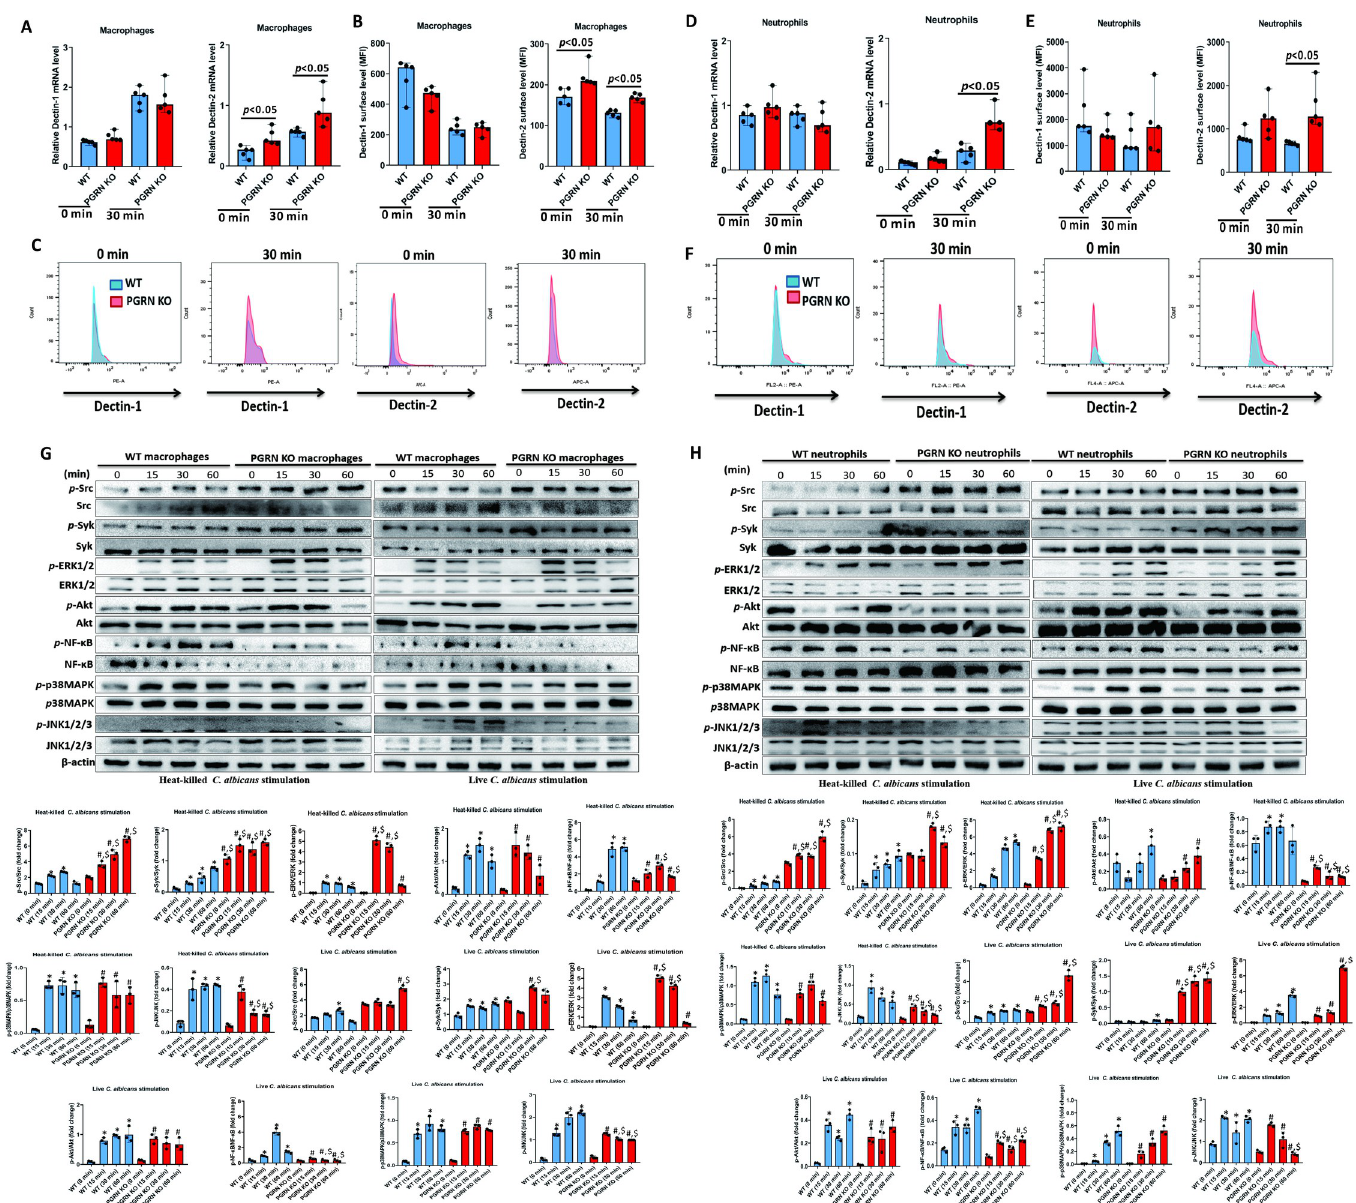
Fig 8. PGRN deletion enhanced Dectin-2 expression and Syk phosphorylation in macrophages and neutrophils. (A) mRNA expression levels of Dectin-1 and Dectin- 2 in WT (n = 5) and PGRN-deficient (n = 5) BMDM with and without heat-killed C . albicans yeast stimulation (at a multiplicity of infection of 1:10). The Mann–Whitney U test was used to analyze the difference between groups denoted by horizontal lines. (B) Surface expression levels of Dectin-1 and Dectin-2 in WT (n = 5) and PGRN- deficient (n = 5) BMDM with and without heat-killed C . albicans yeast stimulation (at a multiplicity of infection of 1:10). The Mann–Whitney U test was used to analyze the difference between groups denoted by horizontal lines. MFI = mean fluorescence intensity. (C) Representative figures of Dectin-1 and Dectin-2 expression on BMDM (n = 5) analyzed by surface staining and flow cytometry. (D) mRNA expression levels of Dectin-1 and Dectin-2 in WT (n = 5) and PGRN-deficient (n = 5) neutrophils with or without heat-killed C . albicans yeast stimulation (at a multiplicity of infection of 1:10). The Mann–Whitney U test was used to analyze the difference between groups denoted by horizontal lines. (E) Surface expression levels of Dectin-1 and Dectin-2 in WT (n = 5) and PGRN-deficient (n = 5) neutrophils with or without heat- killed C . albicans yeast stimulation (at a multiplicity of infection of 1:10). The Mann–Whitney U test was used to analyze the difference between groups denoted by horizontal lines. (F) Representative figures of Dectin-1 and Dectin-2 expression on neutrophils (n = 5) analyzed by surface staining and flow cytometry. (G) WT or PGRN- deficient BMDM were stimulated with either live or heat-killed C . albicans (at a multiplicity of infection of 1:10) for the indicated times, and phosphorylation levels of Src, Syk, Akt, ERK1/2, NF- κ B-p65, JNK and p38MAPK were determined with phosphospecific antibodies by Western blot analysis. The intensity of the proteins was measured, and data from three independent experiments were analyzed with a one- way ANOVA followed by Tukey’s test. � p < 0.05 when compared with WT cells at 0 min. # p < 0.05 when compared with PGRN KO cells at 0 min. $ p < 0.05 when compared between PGRN KO cells and WT cells at the same time point. (H) WT or PGRN- deficient neutrophils were stimulated with either live or heat-killed C . albicans (at a multiplicity of infection of 1:10) for the indicated times, and phosphorylation levels of